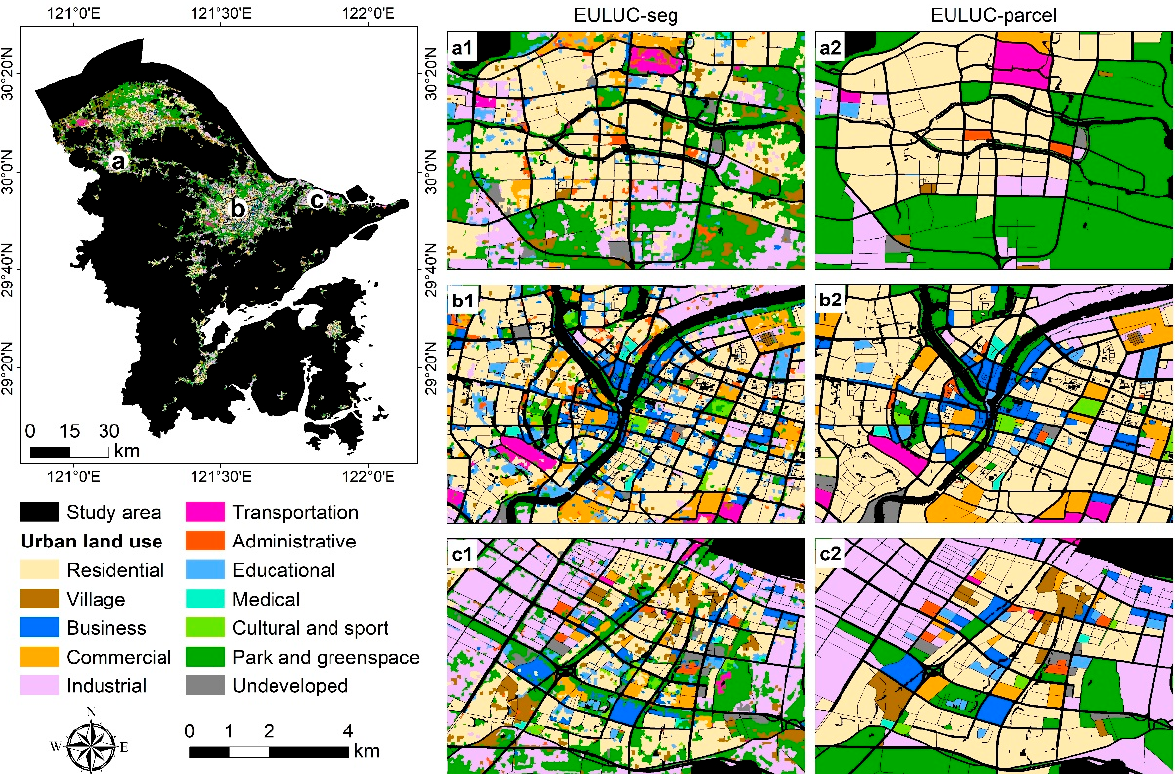
Figure 4. The two-stage urban land use mapping results for Level II categories in Ningbo. ( a1 , a2 ) The Yuyao county located ~40 km west of the city center. ( b1 , b2 ) The central urban area of Ningbo where three main rivers (Fenghua river, Yong river, and Yao river) run through. ( c1 , c2 ) The Beilun district located ~30 km east of the city center.